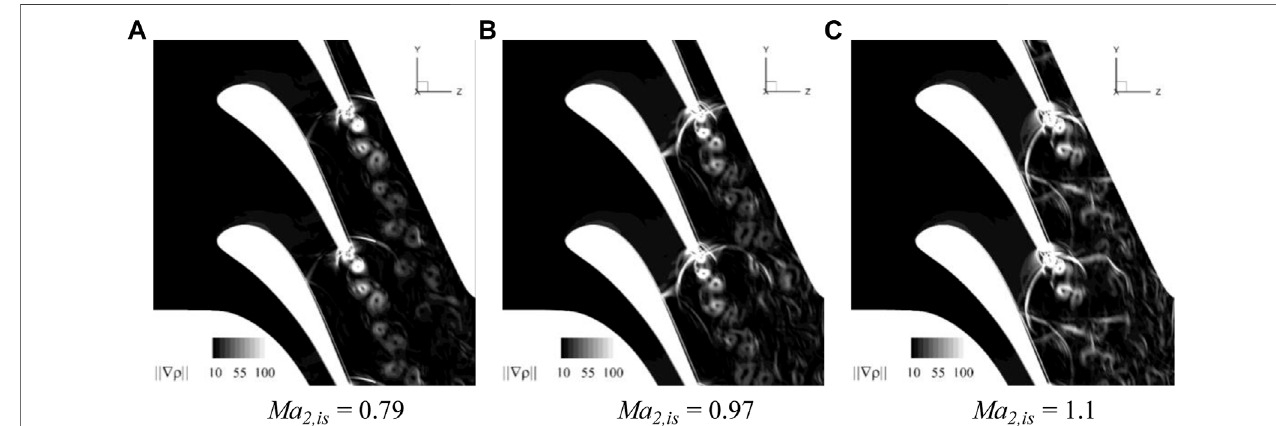
FIGURE 14 | Numerical Schlieren at different Mach numbers for the prototype. (A) Ma2,is (cid:1) 0.79 (B) Ma2,is (cid:1) 0.97 (C) Ma2,is (cid:1) 1.1.